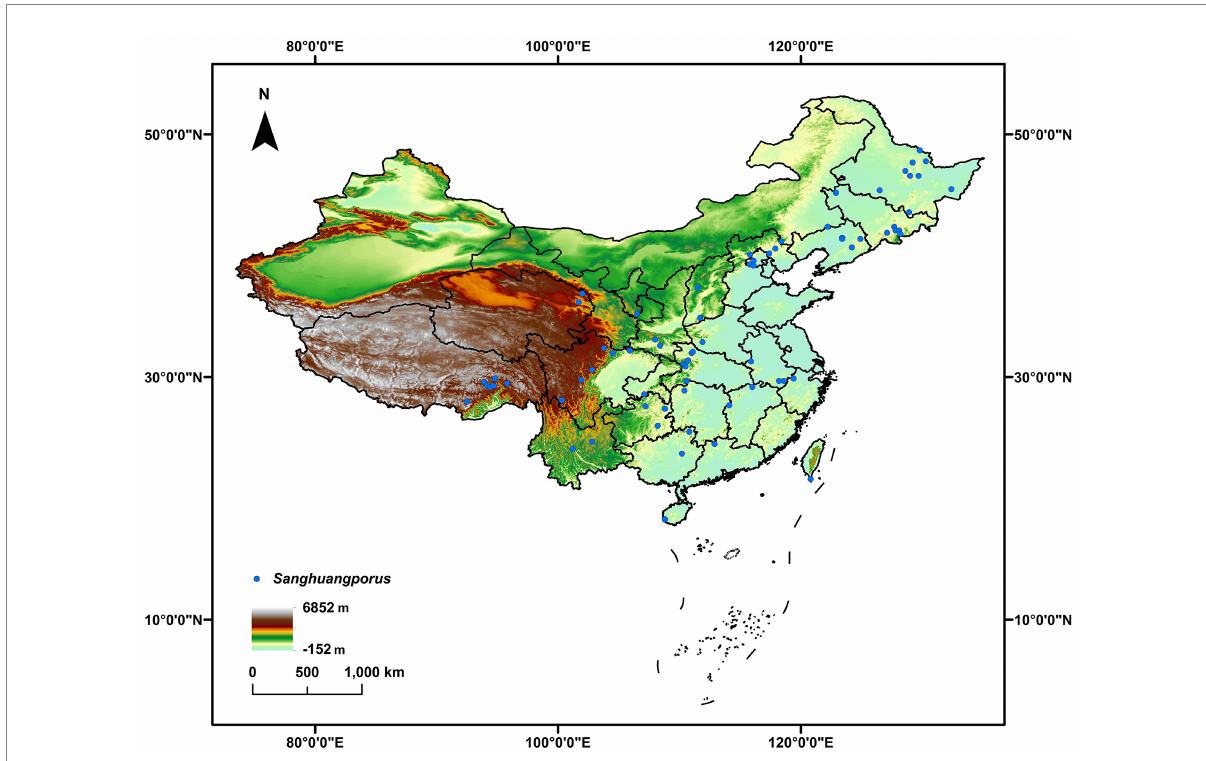
FIGURE 1 The known occurrence records of Sanghuangporus (blue circle) used for modeling the geographic distribution of this fungal genus in